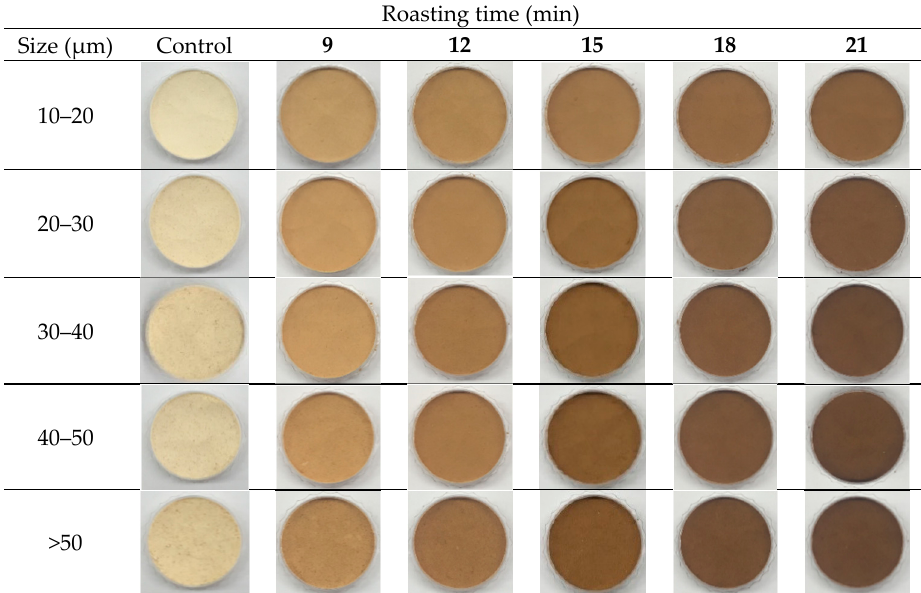
Figure 3. Appearance of dried ginseng root powder pretreated with different roasting times.